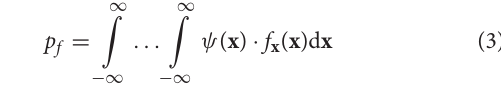
Frontiers in Built Environment |